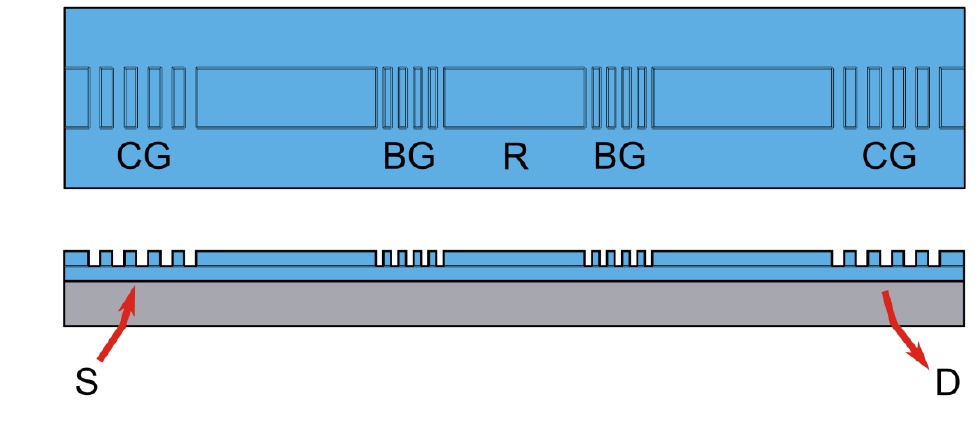
Figure 2. Schematic representation of the sensor (top and side view), comprising a coherent source (S), coupling gratings (CG), Bragg gratings (BG), a resonator (R) and a detector